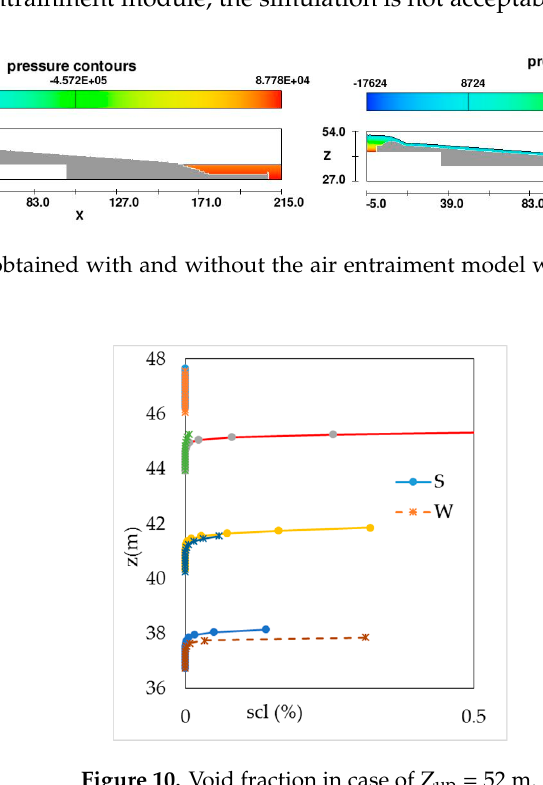
Figure 8. Influence of air entraiment module on numerical results.